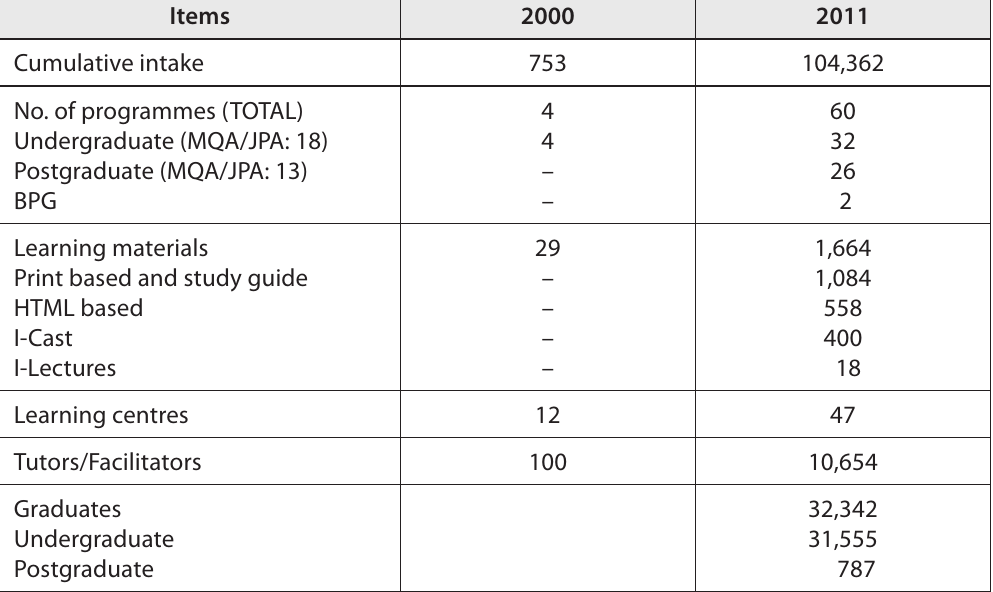
Table 1 OUM’s innovative learning materials and total graduates from 2000 to 2011 Source: May 2012 preview slides,